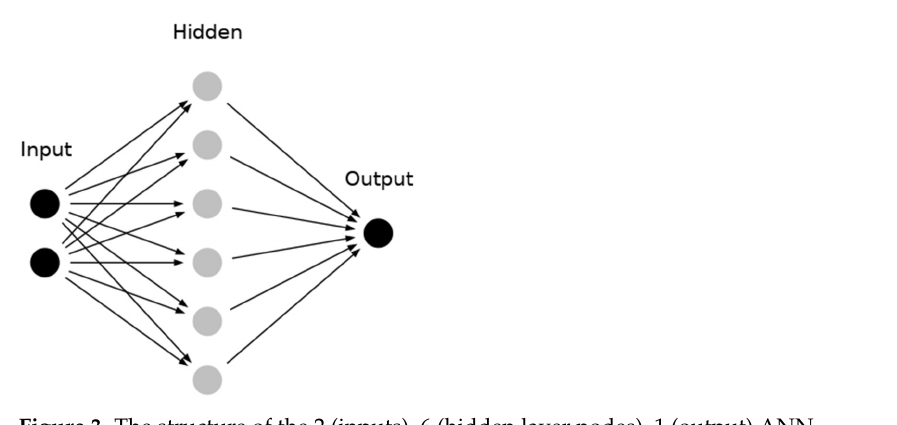
Figure 3. The structure of the 2 (inputs)–6 (hidden layer nodes)–1 (output) ANN.